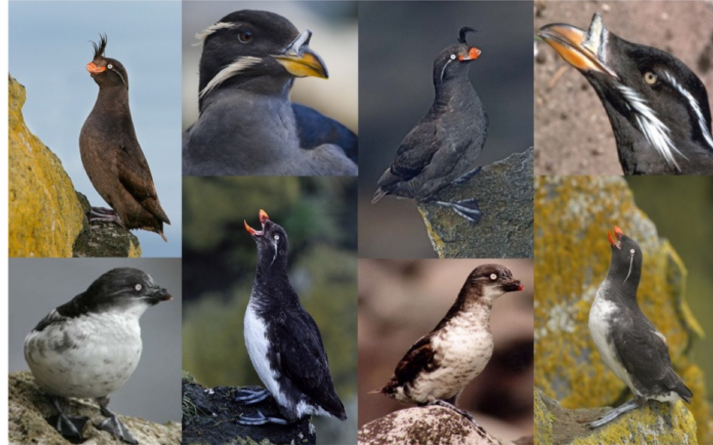
Figure 6. Four different classes of birds in